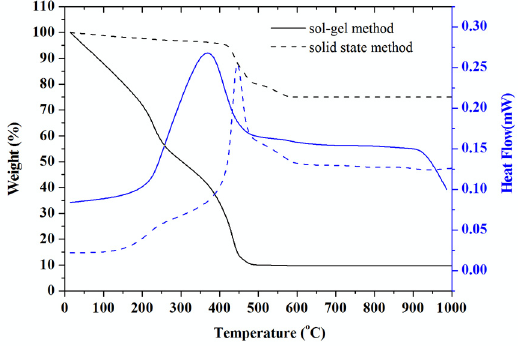
Figure 1. TG–DSC curves of the precursor powder prepared by sol-gel and solid state.